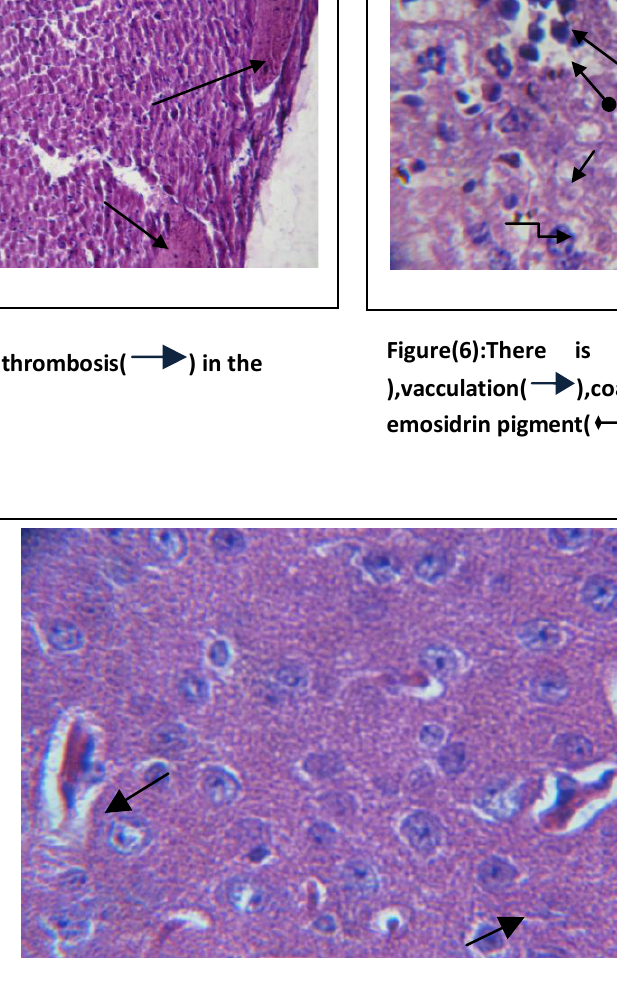
Figure(7):Perivascular odema in the brain( ). (H&E ×40).